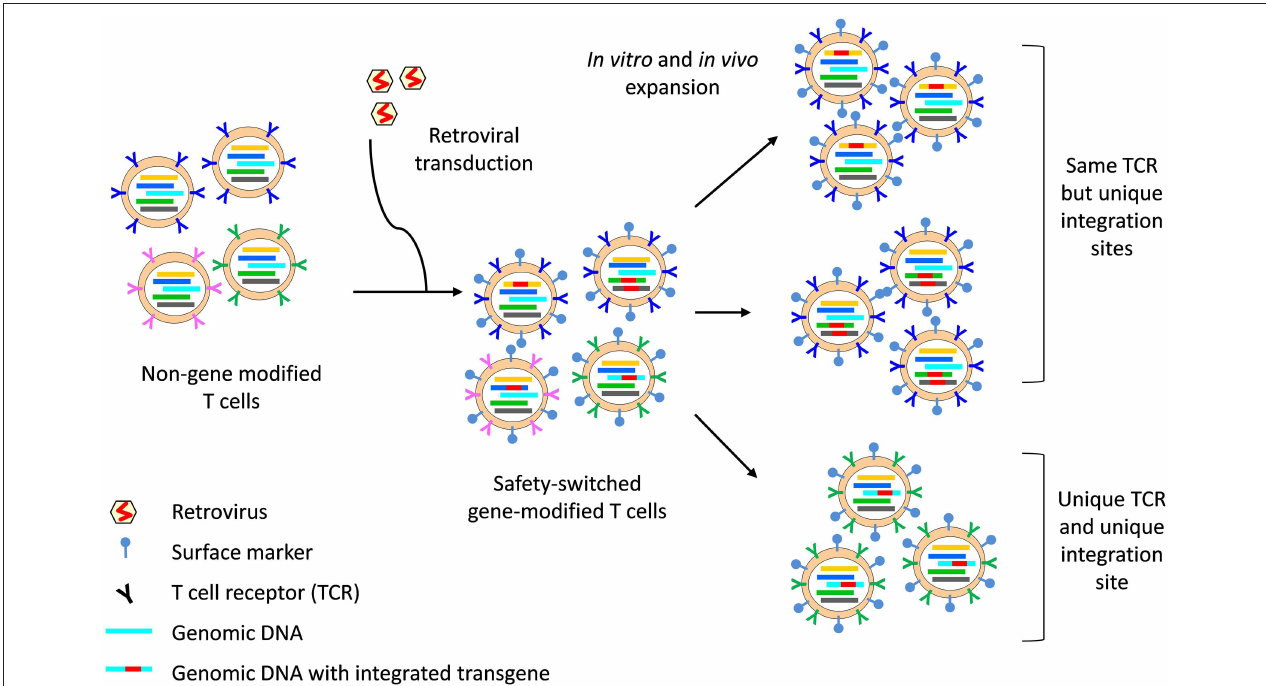
FIGURE 2 | Integration site and TCR analysis on safety switch gene-modified T cells. The safety switch transgene is integrated into the host cell genome, with 1–3 copies of integrants per cell. The region of the genomic DNA in which the transgene integrates (indicated by a unique color) is unique to each integration event and all progenies from that cell can be identified through the unique integration site. Similarly, each T cell bears a unique TCR (indicated by a unique color), which is passed on to all progenies. However, two cells bearing the same TCR may be separately gene-modified, resulting in two clones of T cells which bear the same TCR but with different integration site. Surface markers, for example 1 CD19 or 1 LNGFR, enable identification of safety switch gene-modified T cells by flow cytometry and can be used for cell sort before TCR sequencing. The concurrent analysis of TCR and integration site can provide high resolution data on the clonal origin of safety switch gene-modified T